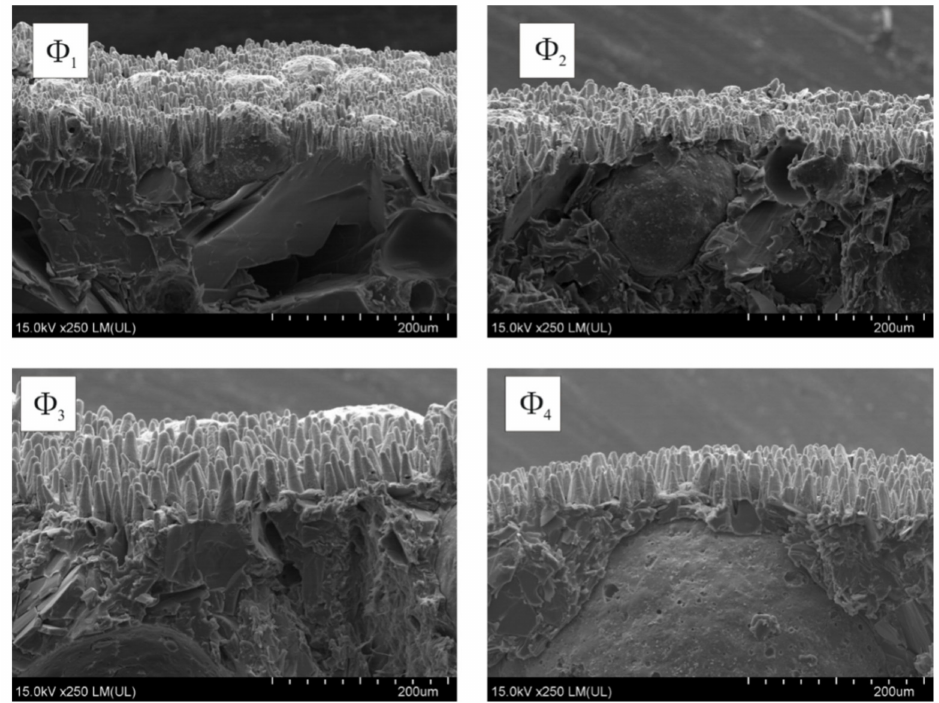
Figure 8. SEM images of laser irradiated (N = 500; E j = 100 mJ/cm 2 ) and metallized coatings containing glass microspheres: Φ 1 , Φ 2 , Φ 3 and Φ 4 (side view).